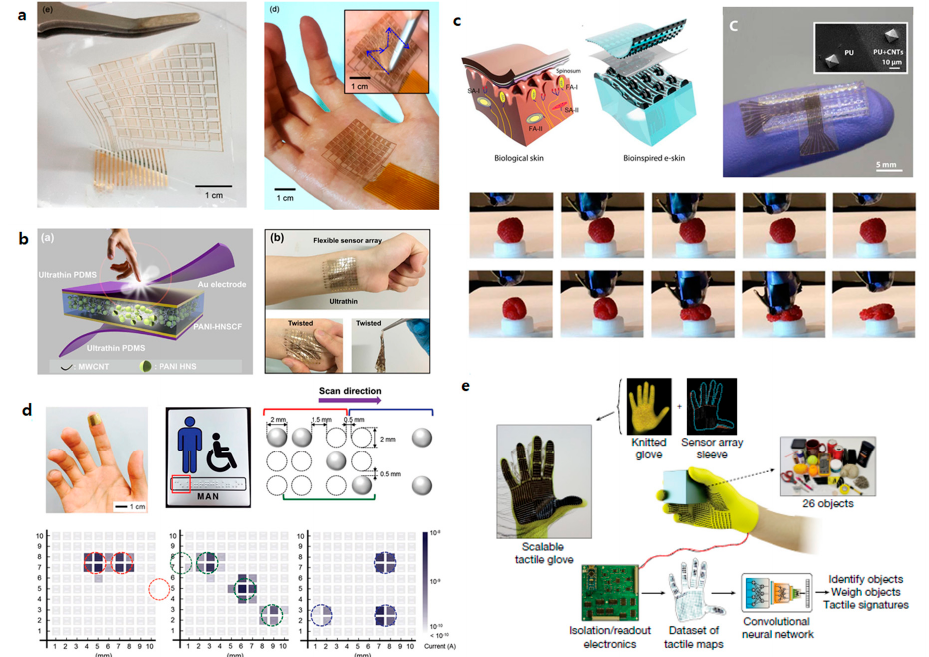
Figure 8. Tactile pressure sensors for e-skin and robotics. ( a ) Photograph of the large area flexible active-matrix (AM) MOS 2 tactile sensor array (left). Photograph of the AM MoS 2 tactile sensor on the human palm (right). ( b ) Primary design concept of flexible e-skin sensor based on polyaniline hollow nanosphere composite films (PANI-HNSCF) (left). Optical image of a wearable ultrathin e-skin sensor array on the wrist and under various mechanical deformations (right). ( c ) Cross-section of the skin of the fingertip depicting key sensory structures and soft biomimetic e-skin (left). Optical image showing carbon nanotube-polyurethane (CNT-PU) interconnects for signal recording with inductance/capacitance ratio (LCR) meter and SEM picture of the top e-skin layer with molded pyramids (right), showing CNT-PU and PU areas (inset). Tactile feedback prevented flattening of the raspberry. Without tactile feedback, the fruit was crushed (bottom). ( d ) Digital image of the flexible tactile array sensor attached to the tip of an index finger as an artificial fingertip (left). Digital image